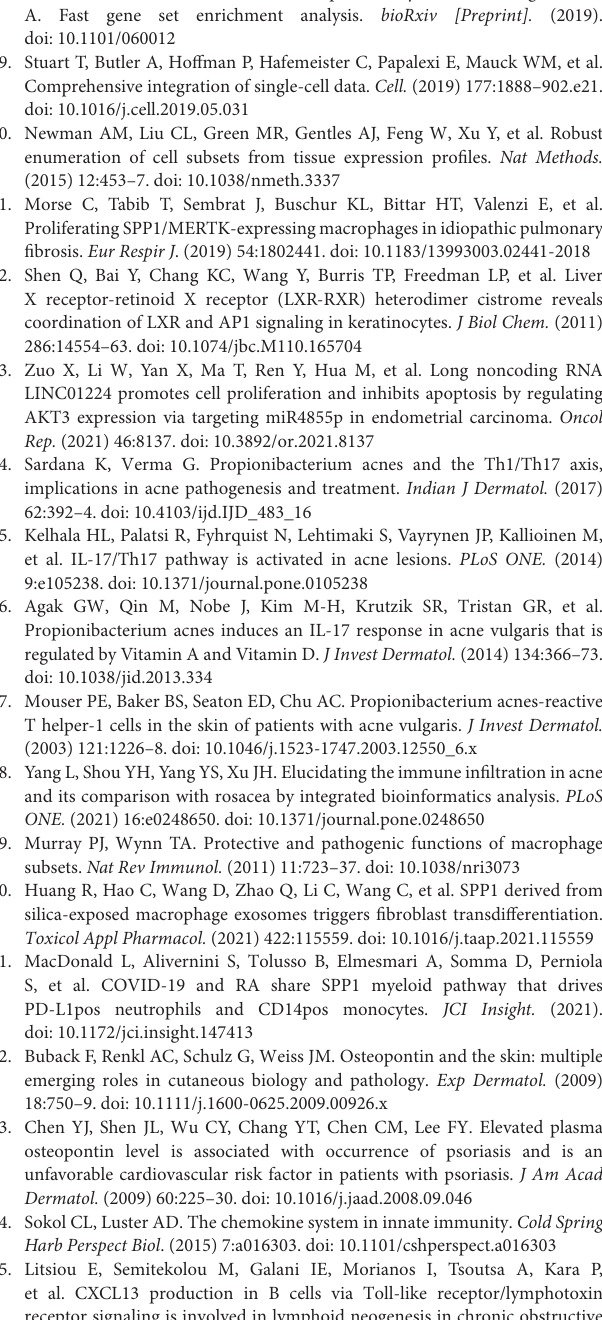
provided in the table correspond to trifarotene gene expression profiles. Molecules listed correspond to genes from the 67 genes of interest mapping to the pathway or function of interest. Supplementary Table 5 | Summary of statistical results for the 69 genes specifically modulated in spontaneously resolved acne papule. L-NI, non-involved skin; L1, papule at baseline; L3, papule after treatment with vehicle.